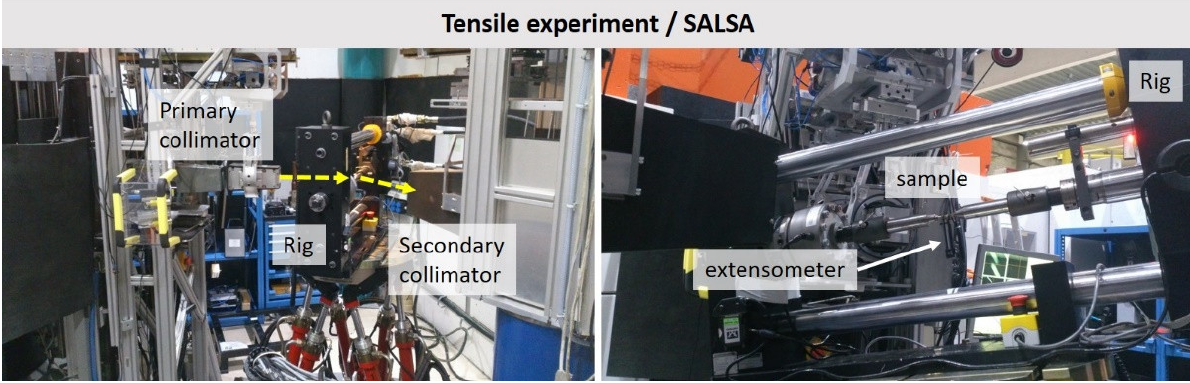
Figure 5. Experimental set-up used at SALSA for the in situ diffraction experiment during uniaxial tensile loading for the longitudinal component.